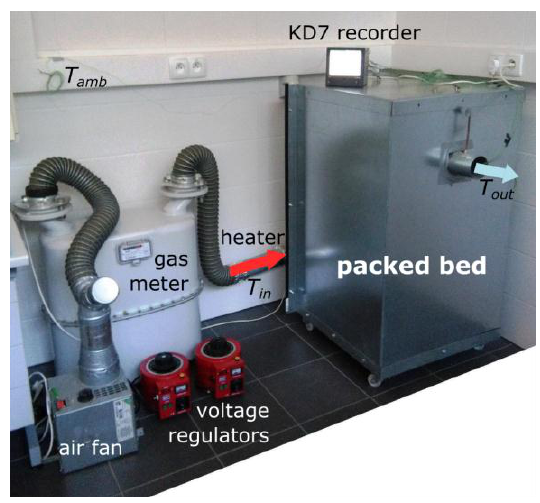
Figure 3. Experimental set-up.